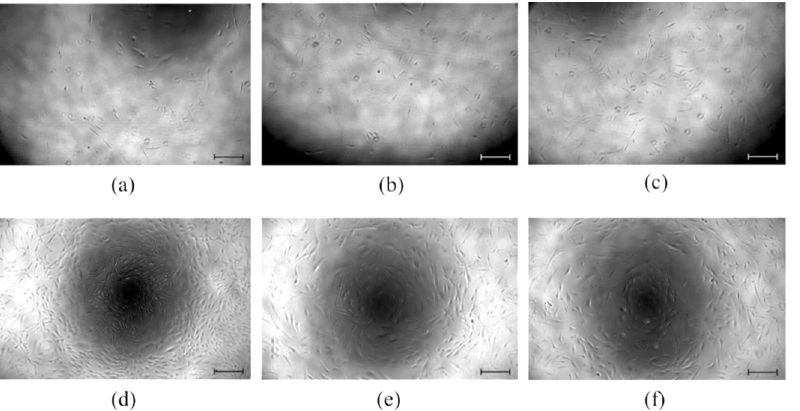
Figure 5. Morphological study of NHDF cells after 24 h in the presence of ( a ) pure cell medium (control) and release medium of ( b ) 203.75 g/m 2 sample, ( c ) 295.5 g/m 2 sample and after 72 h in the presence of ( d ) pure cell medium (control) and release medium of ( e ) 203.75 g/m 2 sample and ( f ) 295.5 g/m 2 sample (scale bar is 200 μ m).